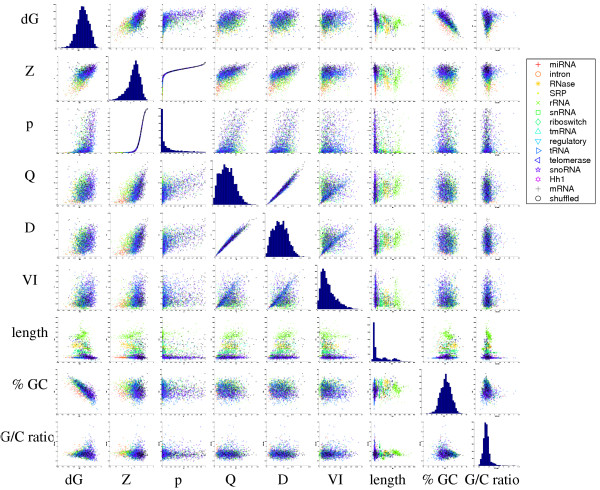
Correlations between measures. Correlations between all the different measures for all the data sets are shown. The diagonal figures show the distributions of the measures.